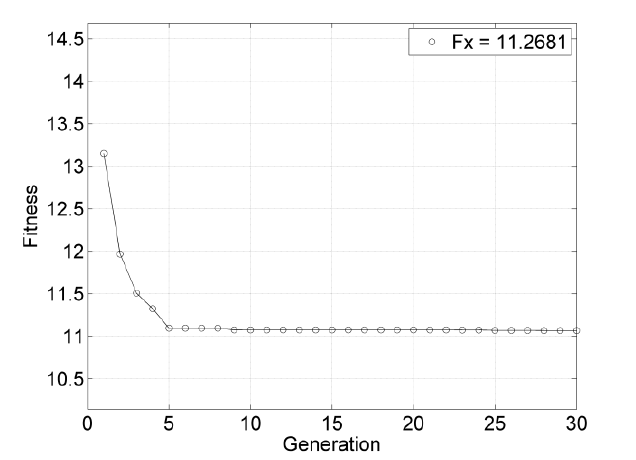
Fig. 11. GA fitness evolution (GA for  , kp and ki ).